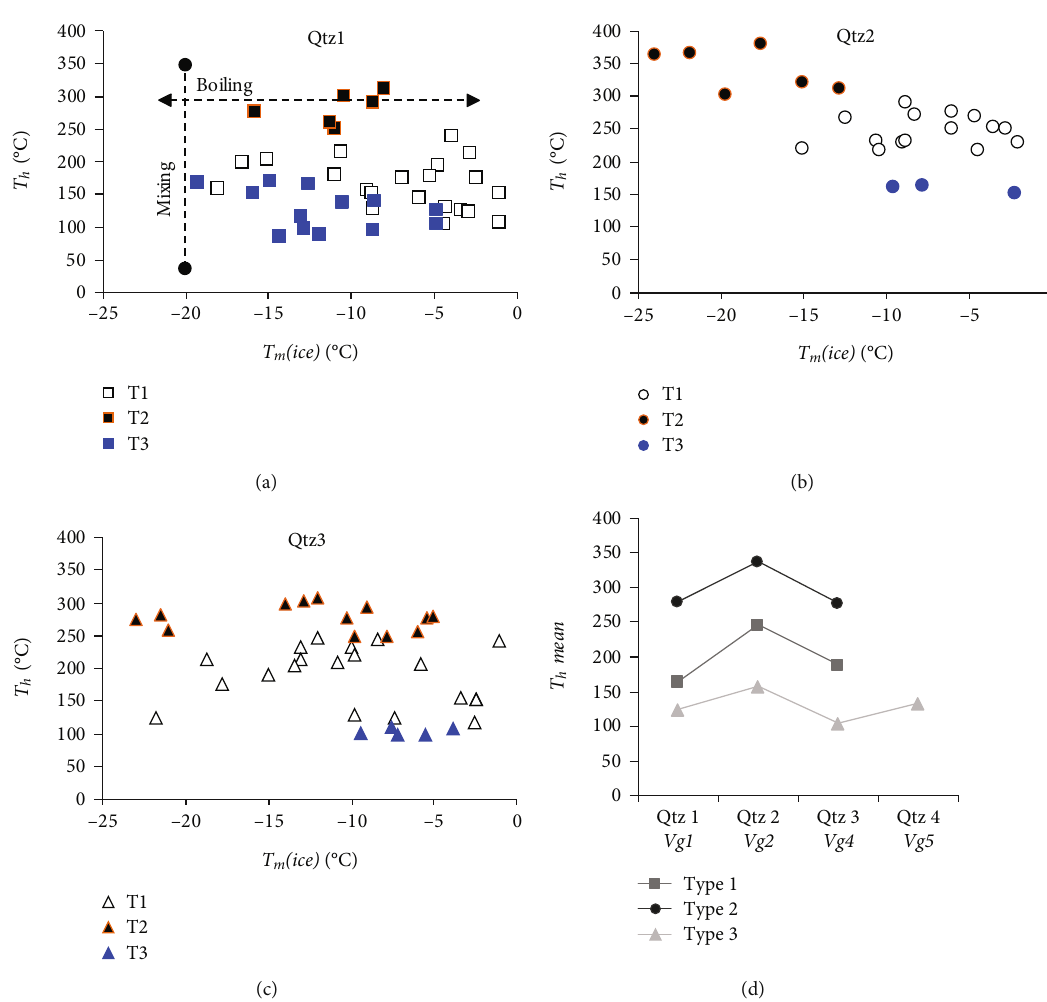
Figure 10: Plot of representative microthermometric data of type 1, type 2, and type 3 fl uid inclusions in T Quartz-chlorite-mineralised vein (Qtz1 and vg inclusion types in all quartz veins (see description in the